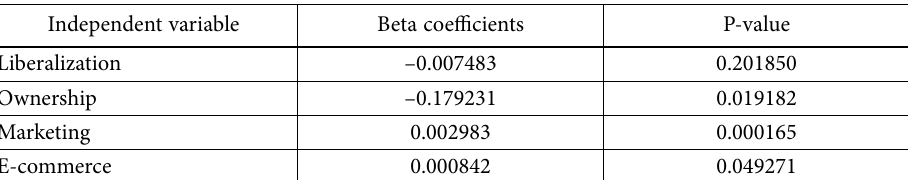
Table 7. Multiple regression analysis results for the determinants of efficiency change (source: calculated by the authors based on data from Universal Postal Union (2019)) Independent